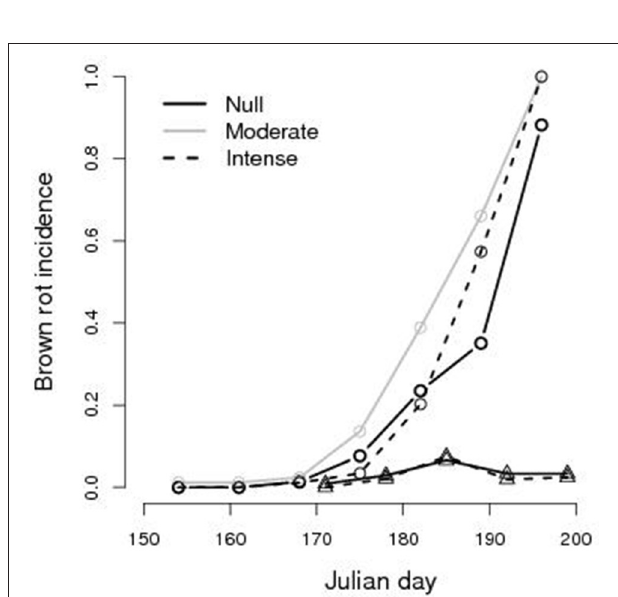
FIGURE 3 | Brown rot incidence (fraction of infected fruits) on monitored fruits of peach Prunus persica trees, during the vegetative season after the date of thinning (e.g., JD 136 for 2014 and JD 153 for 2015), in an orchard non-treated with fungicide. Circles: 2014 data; triangles: 2015 data.